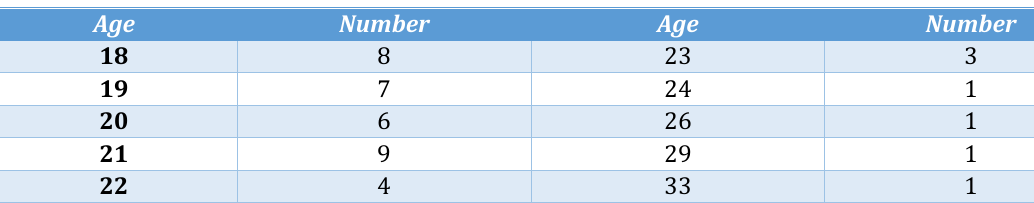
Table 1: Age distribution